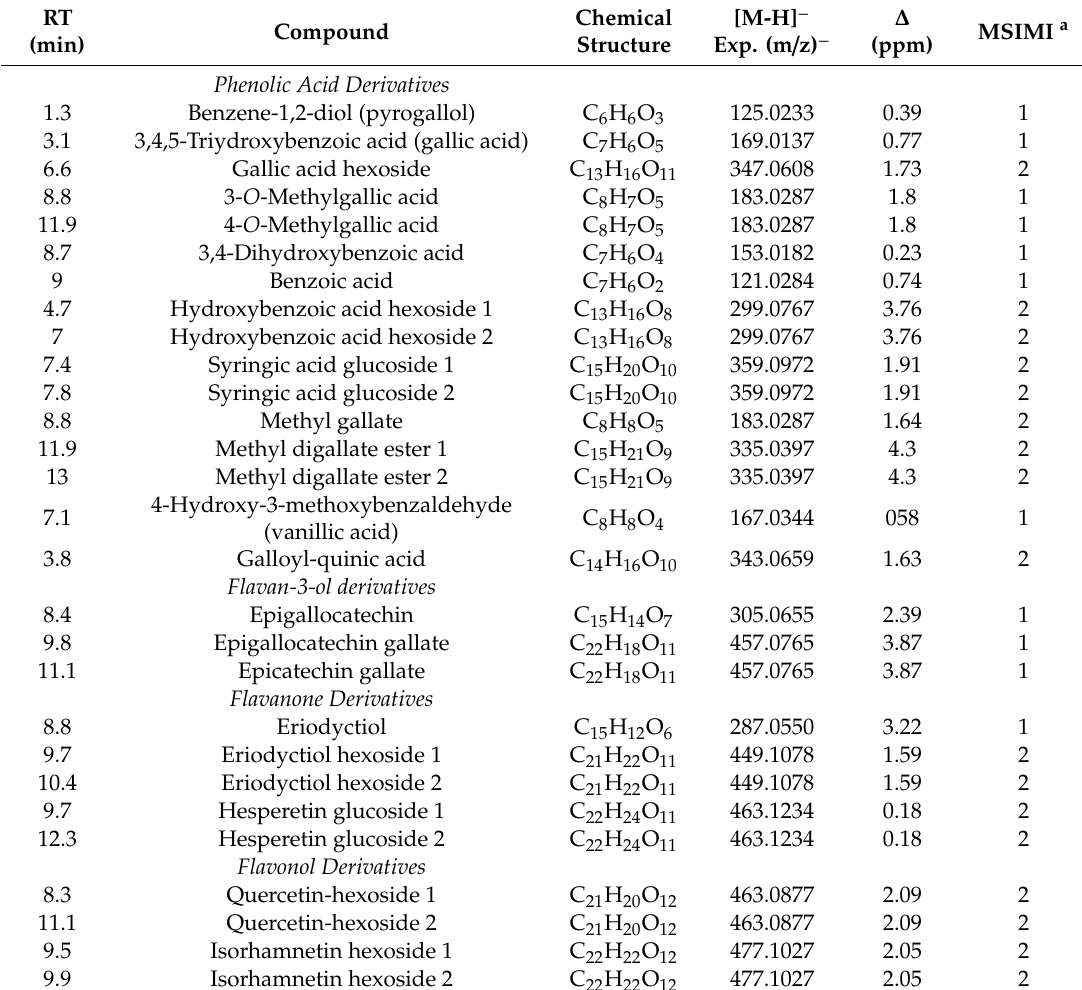
Table 1. UHPLC-HRMS Characteristics of Polyphenol Compounds Identified and Quantified in